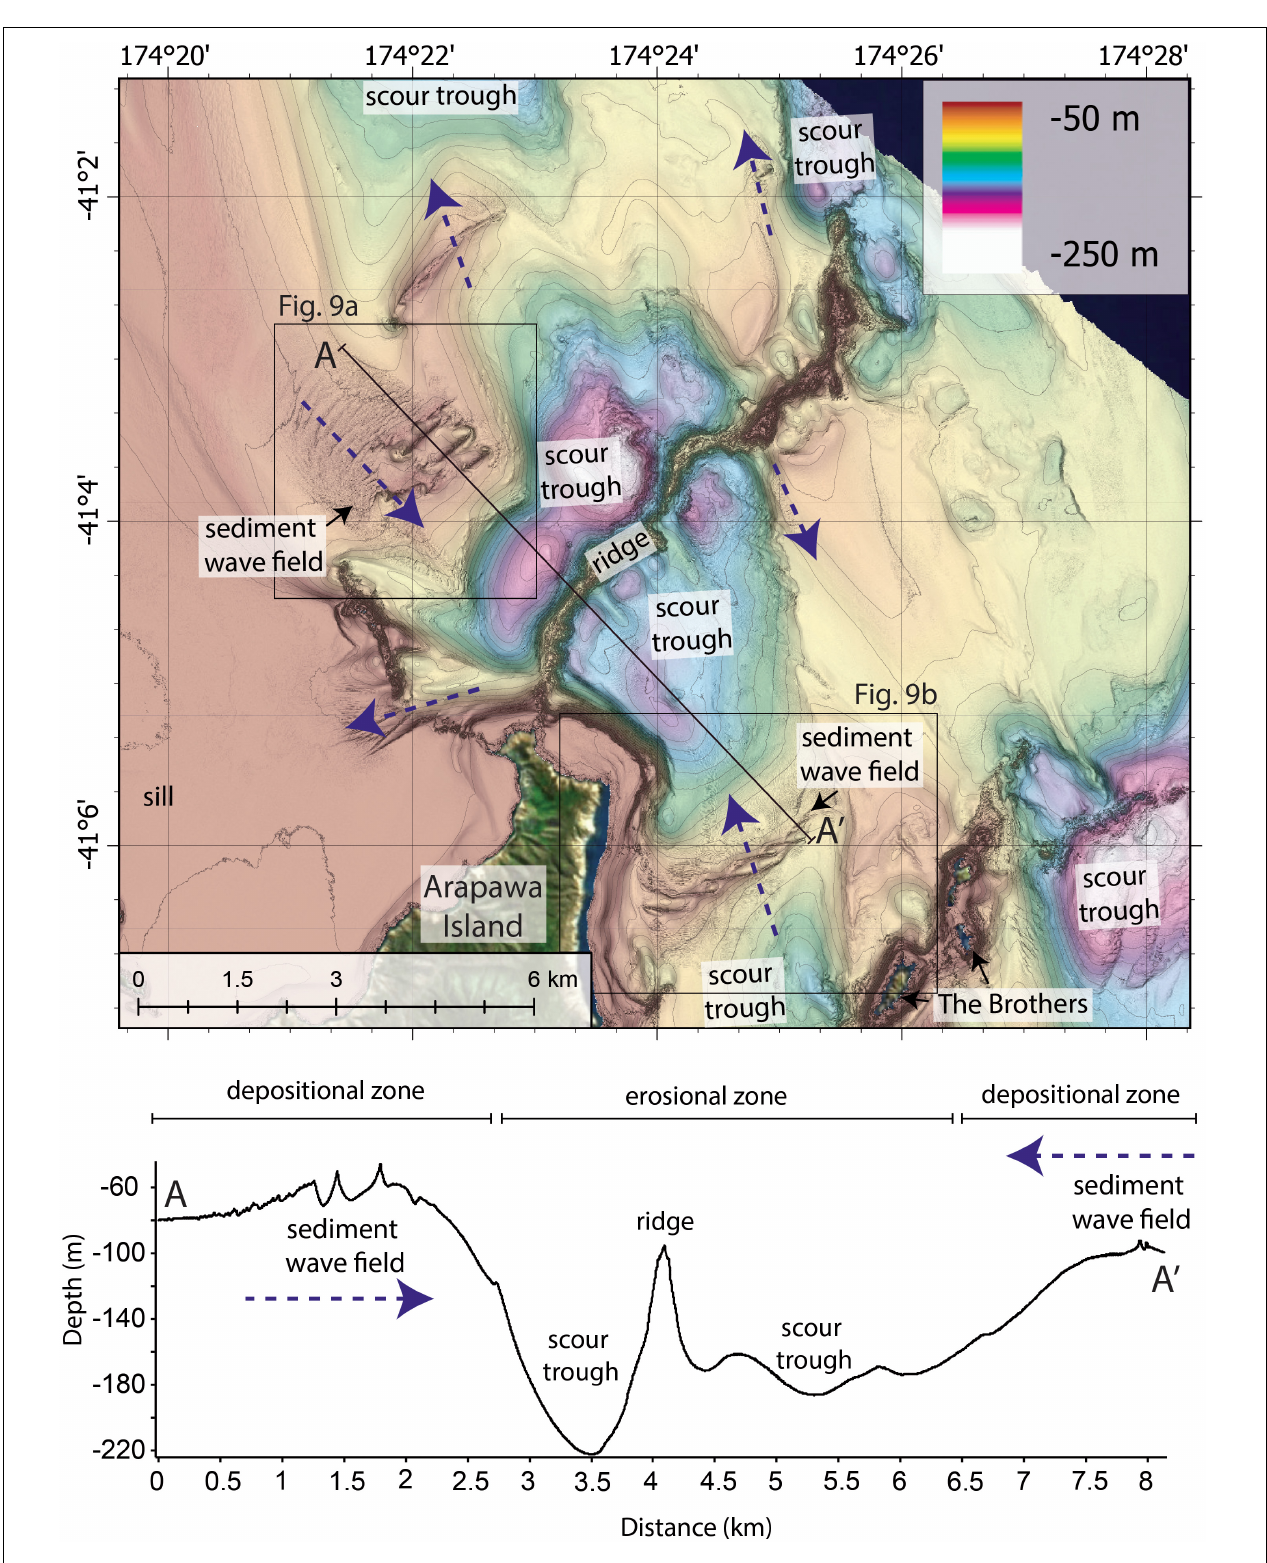
FIGURE 8 | Detailed view of the submarine ridge extended from Arapawa Island. Black lines are 10 m bathymetric contours and black rectangles show the location of Figures 9A,B . The location of Profile A-A’ is shown, which shows mirrored sediment wave-trough-ridge sequences that are symmetrical about the submarine ridge. Navy blue arrows show the dominant transport direction as interpreted from seafloor geomorphology.